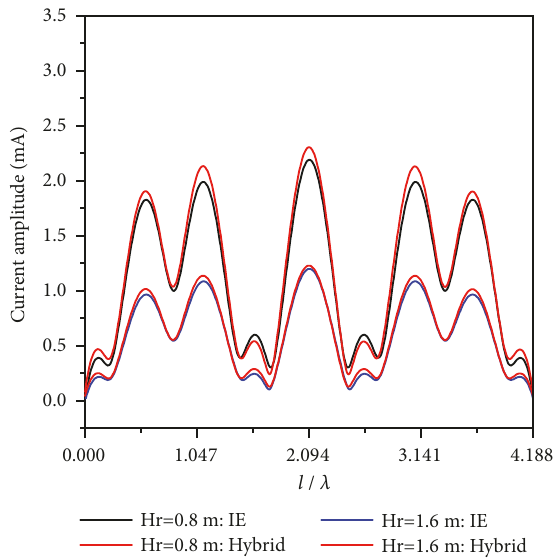
Figure 6: Currents induced on the curved conductor.